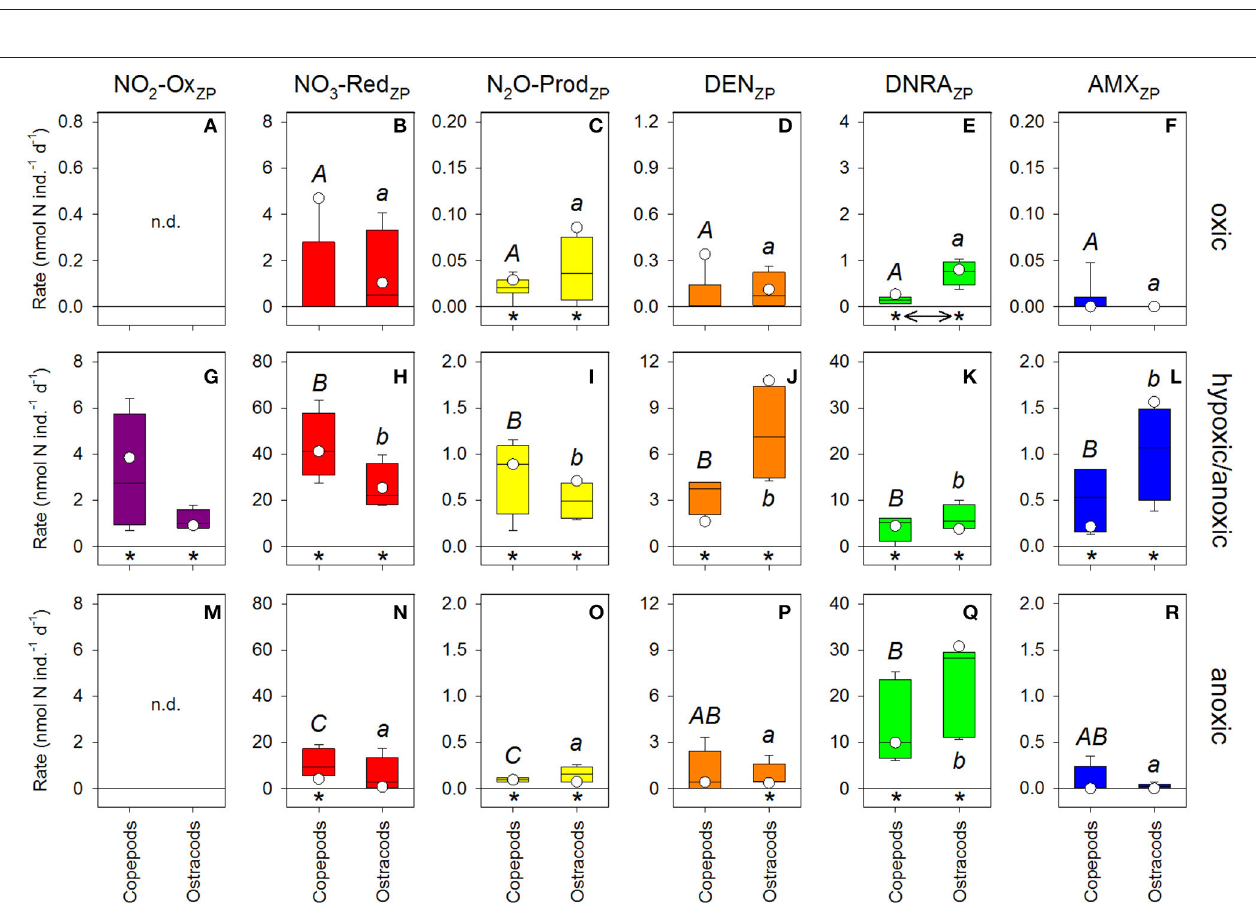
FIGURE 3 | Individual-specific N-cycling rates. Zooplankton carcasses were incubated in seawater collected in (A–F) oxic, (G–L) hypoxic/anoxic, and (M–R) anoxic layers in GD and maintained at near- in situ O 2 concentrations and temperatures. 15 NO − 2 was added as tracer. Box plots show median (black line), 10 th , 25 th , 75 th , and 90 th percentiles as vertical boxes with error bars; n = 4–6. White circles show incubations in 0.2- µ m-filtered seawater. Rates significantly different from zero are marked with an asterisk; significantly different rates between copepods and ostracods are marked with a double arrow; significantly different rates between water layers are marked with different upper-case (copepods) and lower-case letters (ostracods). n.d., not detected.